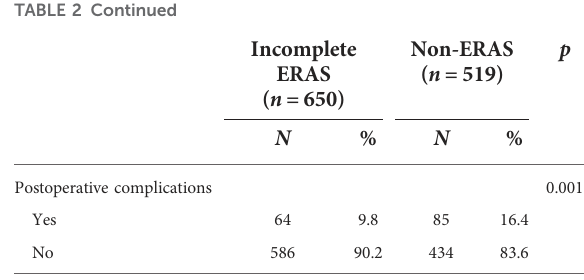
The subgroup analysis of postoperative complications revealed